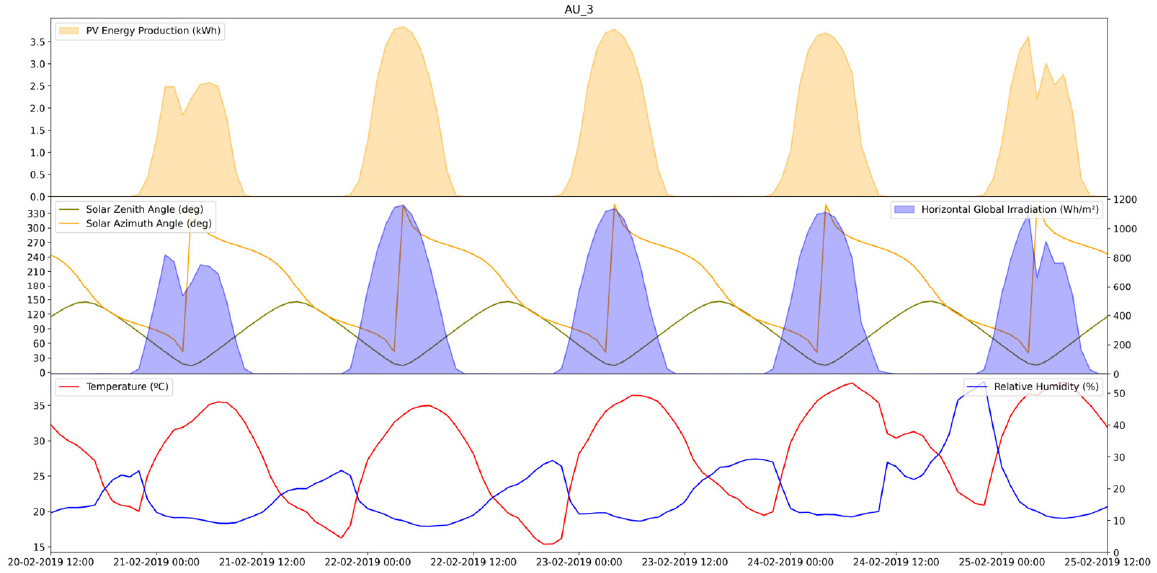
Figure 4. PV energy production (kWh), horizontal global irradiation (Wh/m 2 ), solar zenith ( ◦ ), solar azimuth ( ◦ ), temperature ( ◦ C), and relative humidity (%) from one of the PV facilities in Australia (AU_3) during five days. Table 2. Dependent and independent variables initially